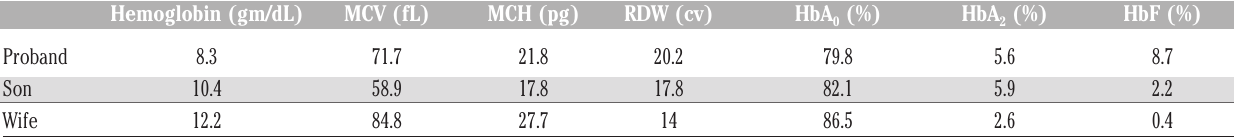
Table 1. Complete hemogram of Case 1.